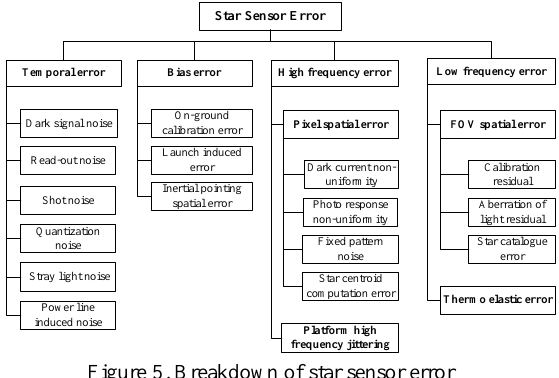
Figure 5. Breakdown of star sensor error TE is a random error caused by hardware circuit noise and input signal conditions, is independent of spatial motion, and appears as irrelevant white noise in the time domain. BE refers to the inherent deviation of the star sensor’s coordinate system relative to the installed coordinate system caused by environmental factors such as mechanical vibration and gravity. As a satellite should not experience mechanical shock once running on orbit, Figure 4. The calibration result of angles between the star BE can be assumed constant. HFE manifests as pixel spatial errors and platform jittering. Pixel spatial error is due to the sensor’s optical axis and the earth observation camera’s optical spatial inhomogeneity of the detector and the error caused by axis based on ground calibration field